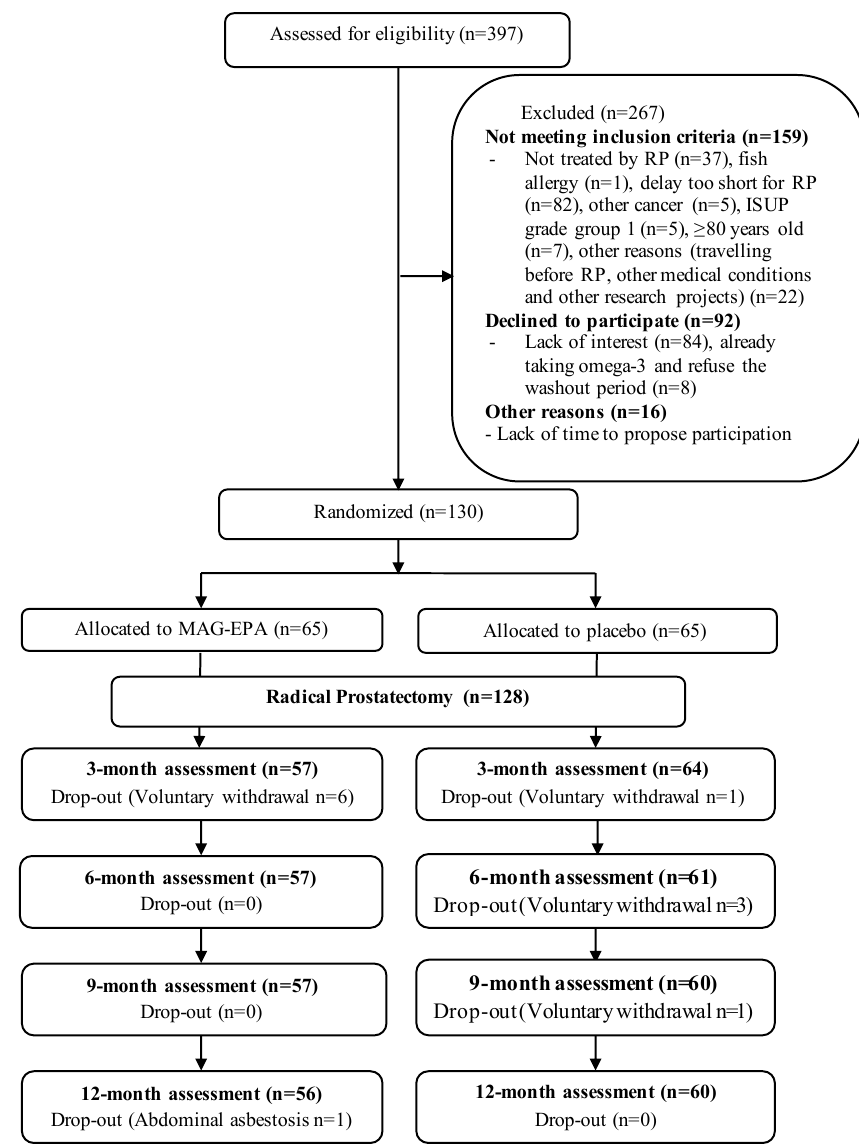
Figure 1. Study’s flow chart. MAG-EPA: monoacylglyceride-conjugated eicosapentaenoic acid; RP: Radical Prostatectomy. ISUP: International Society of Urological Pathology.